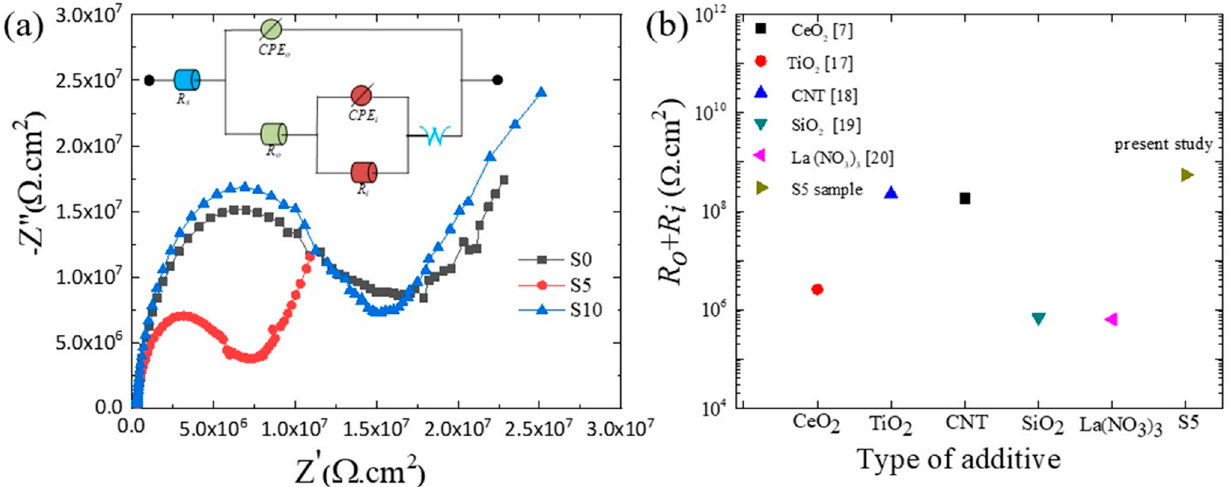
Figure 4. ( a ) Nyquist plots for S0, S5, and S10 samples in a 3.5 wt.% NaCl solution. ( b ) R o + R i vs. additive type. The inset in Figure 4a represents the ECM proposed for fitting the EIS results. Table 2. Results of the EIS tests of the S0, S5, and S10 samples immersed for 6 h in a 3.5% NaCl solution.